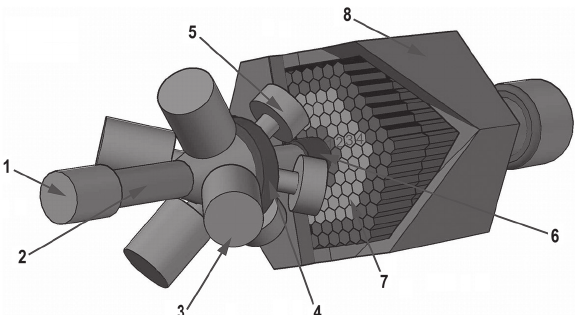
Figure 1. Conceptual design of the fusion-fission hybrid reac - tor facility: 1 – leaky plasma receiver; 2 – longitudinal plasma flow deceleration chamber; 3 – heating atomic beam injectors;